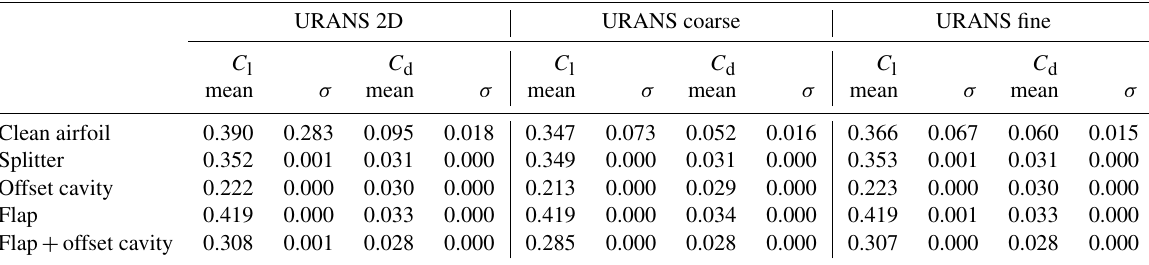
Table A2. Mean and standard deviation ( σ ) values for lift and drag coefficients. Comparison between 2D URANS and URANS on the coarse and fine